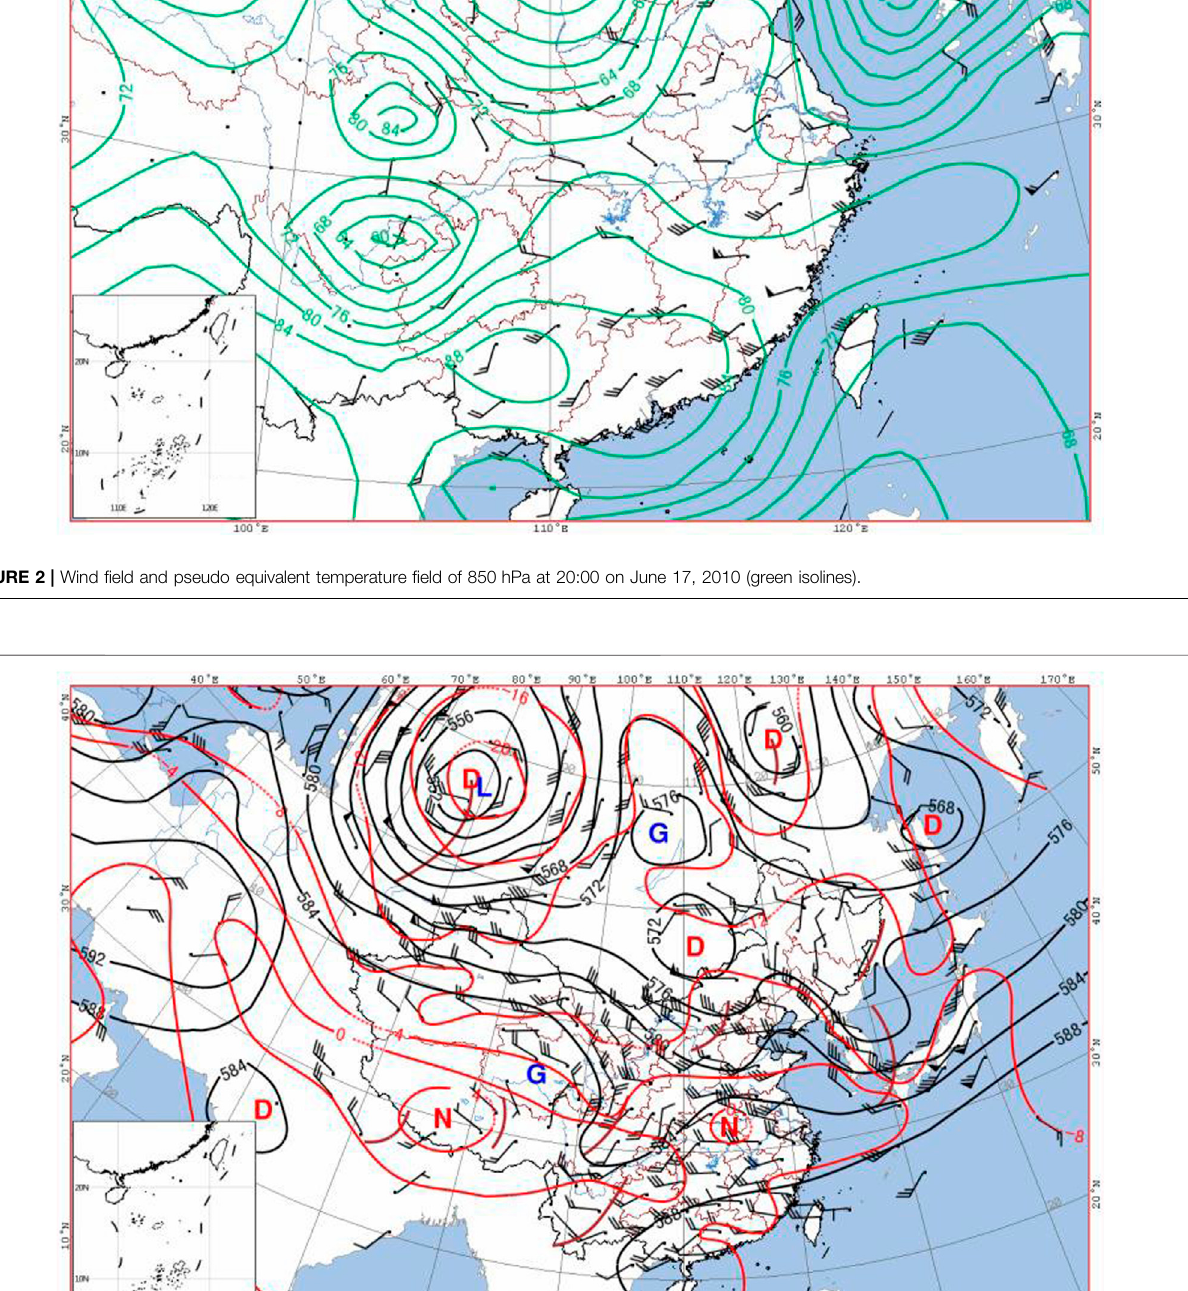
Frontiers in Earth Science |